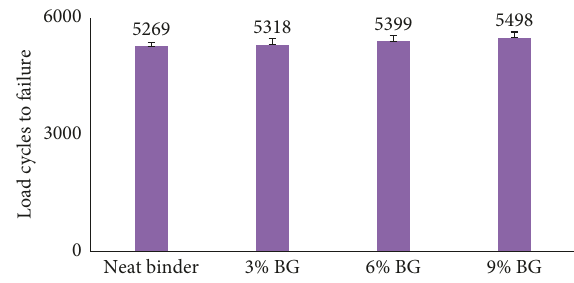
Figure 18: Fatigue life of BG-modified asphalt mixture at 20 °